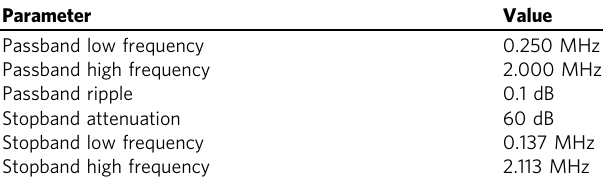
Table 2 Characteristics of the passband fi lter applied to the master ’ s signal and the slave ’ s signal before